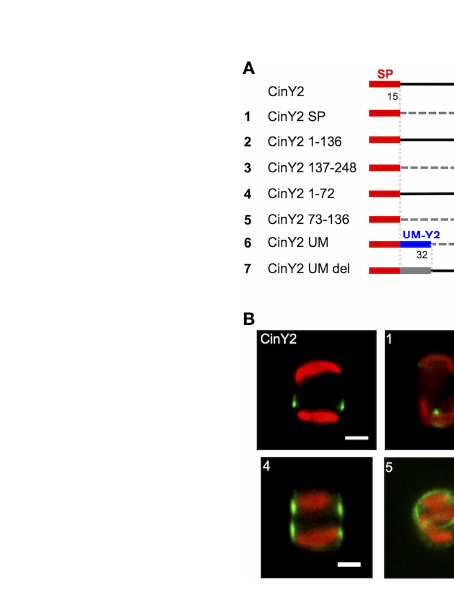
FIGURE 4 Localization experiments with the GFP-fusion constructs derived from CinY2. (A) shows a graphical depiction of the constructs used for the experiments. The color code is: red for the signal peptide (SP), pink for LER1-Y2, purple for LER2-Y2, black for the protein backbone, grey for the parts of the protein that have been deleted. (B) shows girdle band view images (merged eGFP and PAF channels) of live cells selected from in vivo localization experiments performed using the constructs shown in the left panel. Scale bars: 2